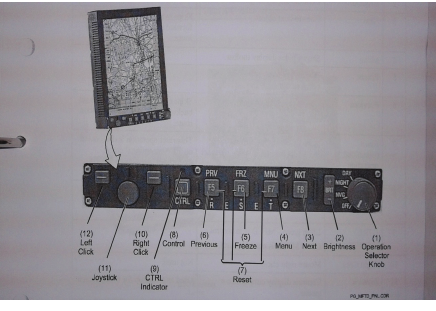
Figure 16 – Fixed-function buttons Рис . 16 – Кнопки с зависимой фиксацией Слика 16 – Фиксно - функционална